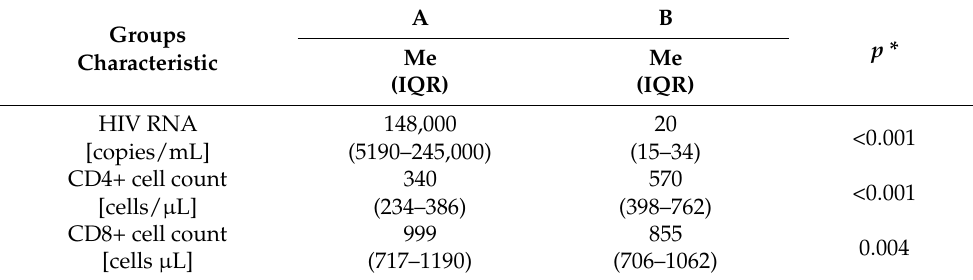
Table 2. Immunological data of HIV-infected men groups before ( A ) and after cART ( B ) with statistical